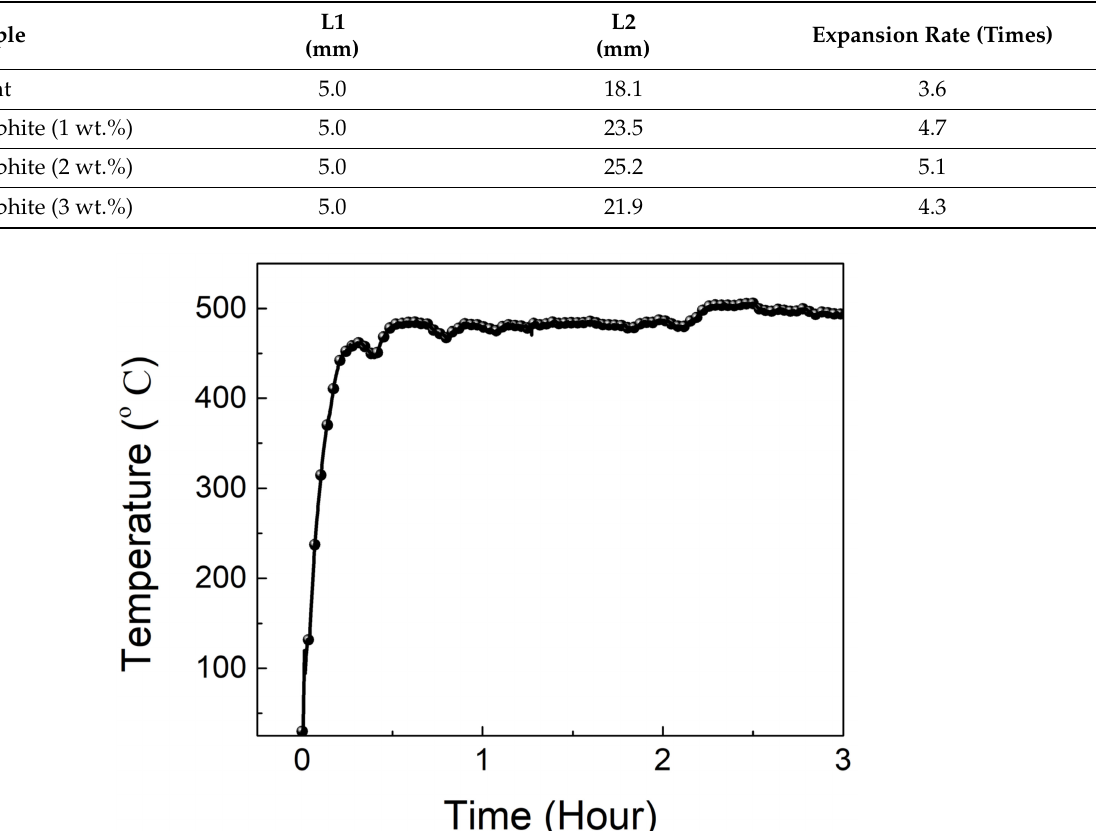
Figure 12. Flame testing of intumescent flame-resistant coatings with the optimal ratio of sodium silicate, ammonium polyphosphate, pentaerythritol, Al(OH) 3 and 1~3 wt.% loading of expandable graphite, respectively. Table 1. Expansion ratio and thickness of intumescent flame-resistant coating before (L1) and after (L2) direct flame testing.